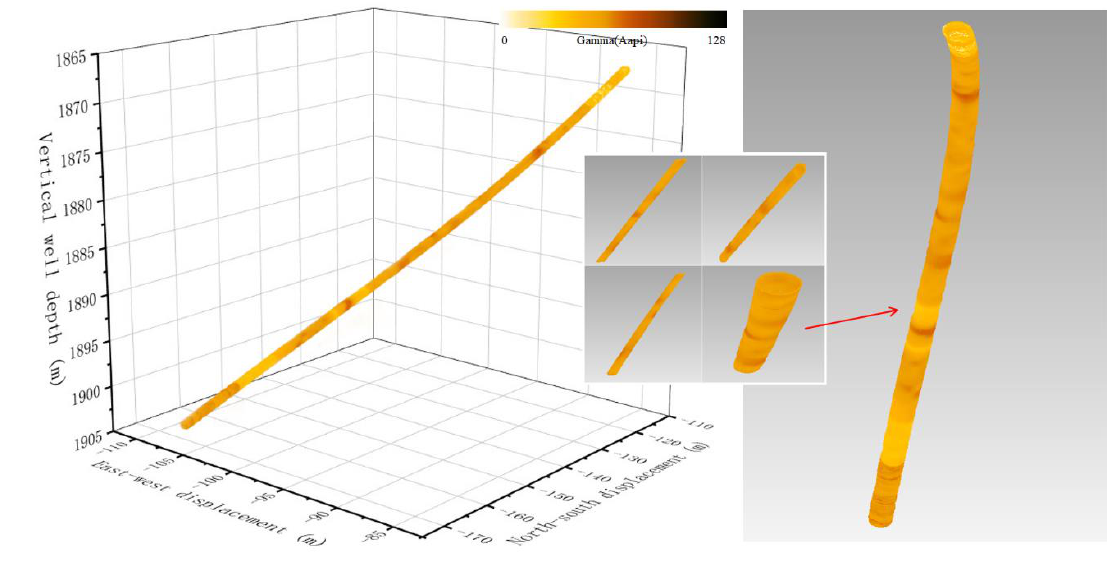
Figure 15. Real-time 3D wellbore structure of the Sheng3-X5 well.